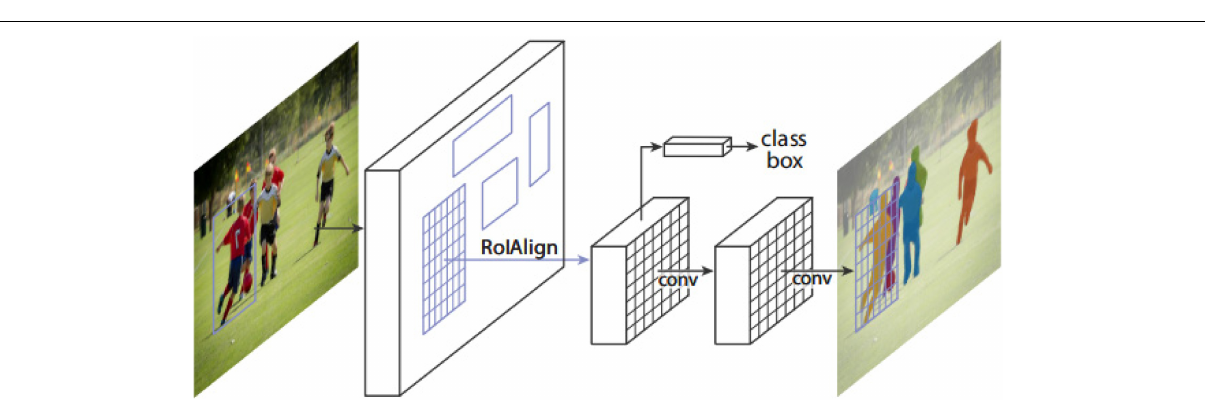
FIGURE 2 | Marking process: (A) early gummosis and (B) end brown rot.